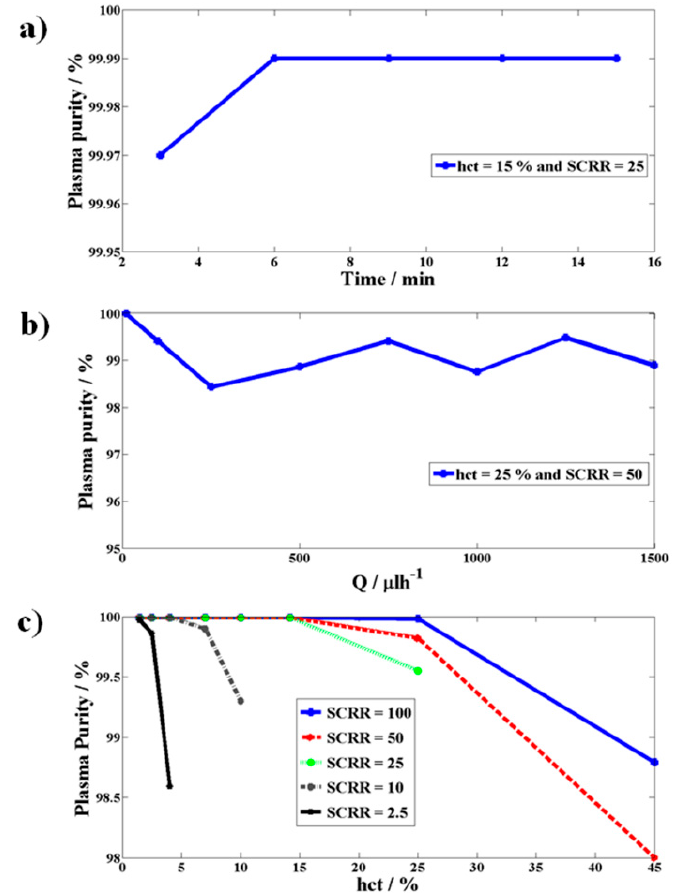
Figure 8. The variation of plasma purity as a function of ( a ) duration of the experiment (time), ( b ) flow rate ( Q ), ( c ) hematocrit ( hct ) and SCRR .